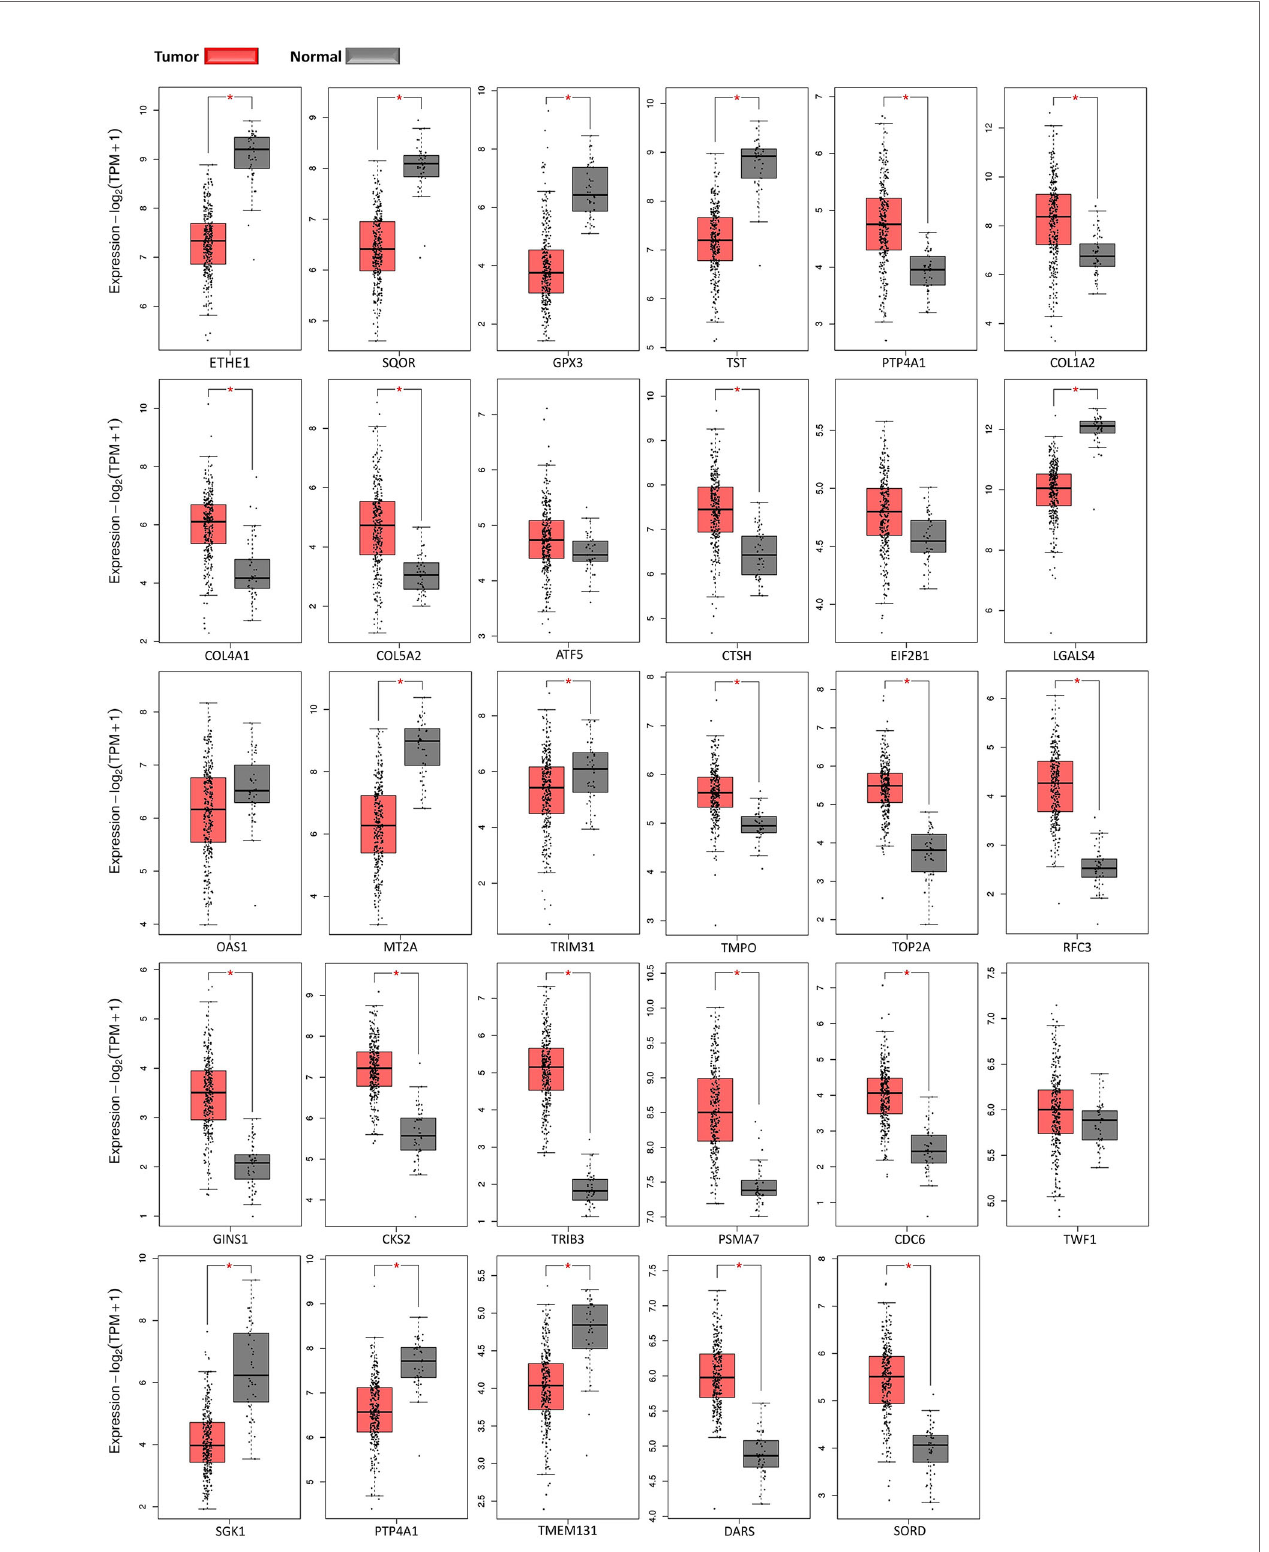
FIGURE 7 | Gene expression pro fi les boxplots. Red boxes present normalized expression values for tumor adenocarcinoma samples and gray boxes present values for normal colon samples.